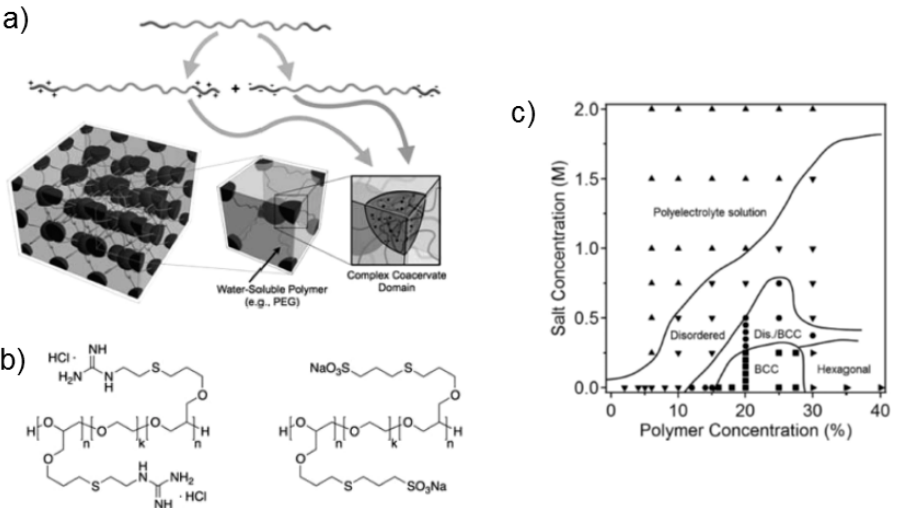
Figure 10. ( a ) Co-assembled system formed by charged triblock copolymers, which were synthesized from the same precursor having a hydrophilic middle block and uncharged end blocks. Schematics of co-assembly of the triblock copolymers having oppositely charged end blocks; ( b ) chemical structures of the charged triblock copolymers having guadinium and sulfonate groups; and ( c ) phase diagram of mixtures of these triblock copolymers in dependence on polymer and NaCl concentration. BCC stands for body-centered cubic. Reprinted with permission from [42]. Copyright 2013 American Chemical